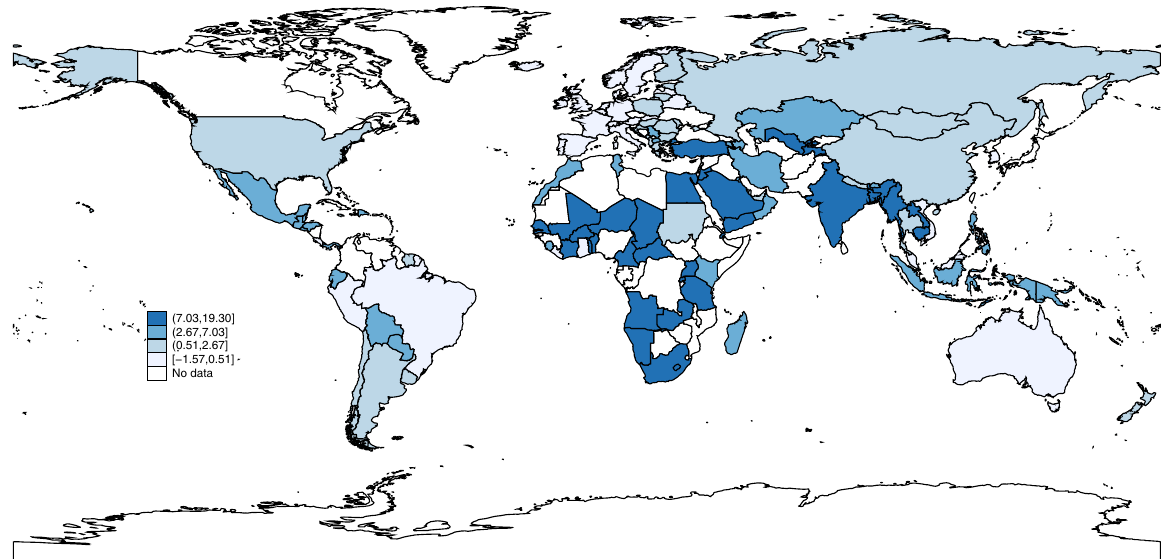
Fig. 4 Cost of inaction in terms of percentage of GDP loss of not reaching universal coverage for pre-primary programmes by country. Note: Children are assumed to enter the labour market at age 18 and 8% bene fi ts are captured for 45 years, calculated with discount rate =